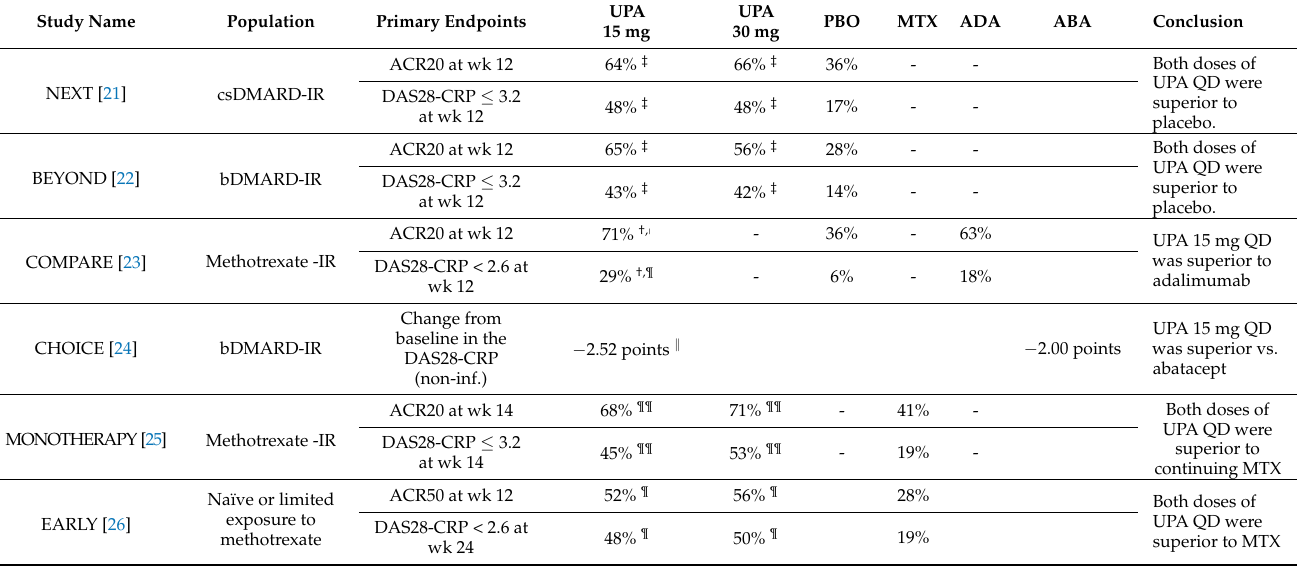
Table 3. Primary efficacy results of the superiority clinical trials from the SELECT program with